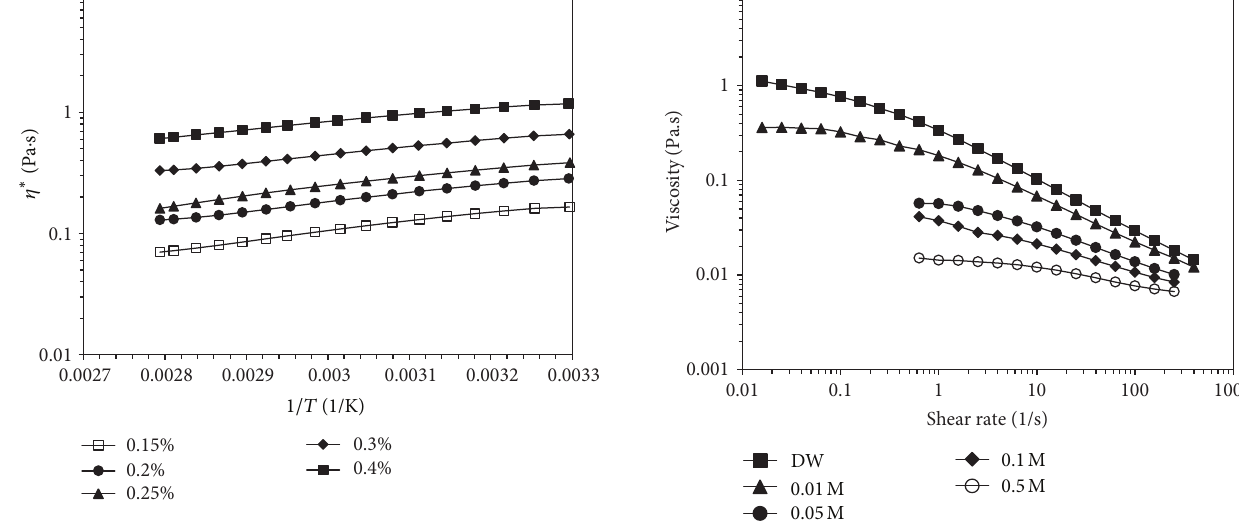
Figure 16: Effect of sodium chloride concentration on steady shear viscosity of copolymer at 50 ∘ C.